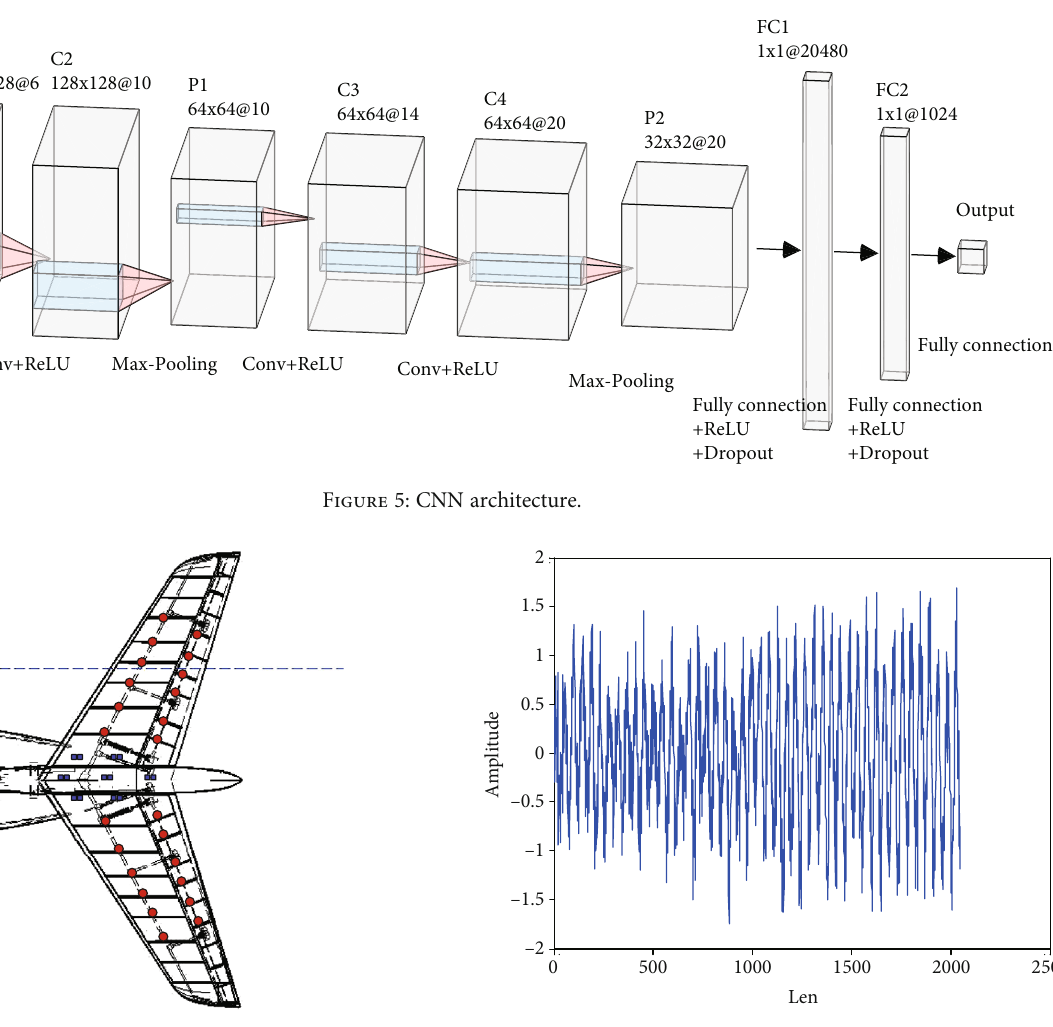
Figure 6: Sensor positions in aeroelastic model. Figure 7: Signal time series when fl utter